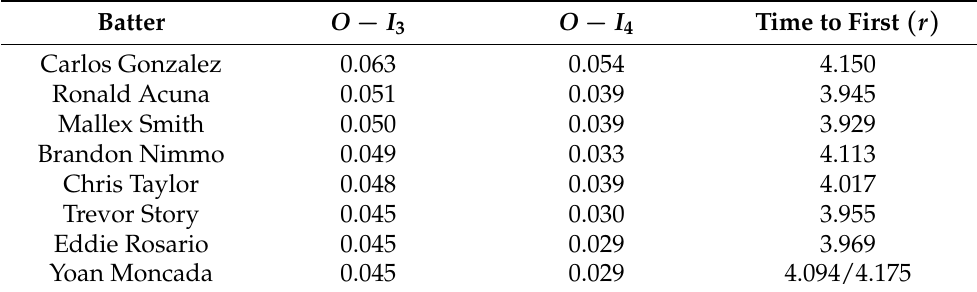
Table 7. Largest differences between observed weighted on base average (wOBA) on contact ( O ) and wOBA cube values ( O − I 3 ) for 2018; differences between O and wOBA tesseract values ( O − I 4 ) ; and time to first ( r ) in seconds; two r values are given for